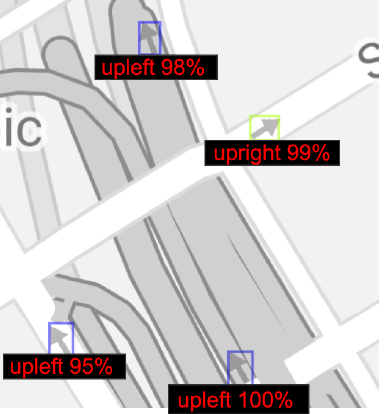
Figure 13. Arrow direction detection for Google Maps.